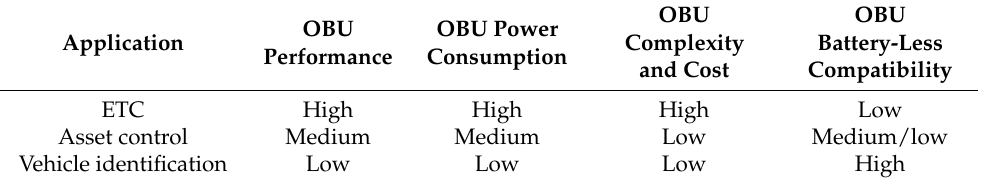
Table 1. Compatibility of on-board unit (OBU) applications with respect to battery-less solutions.